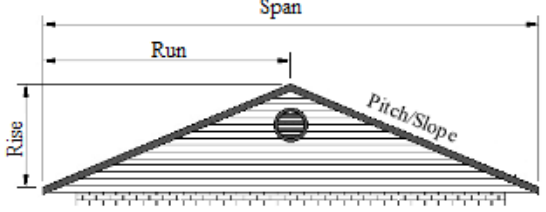
Figure 3. Building roof